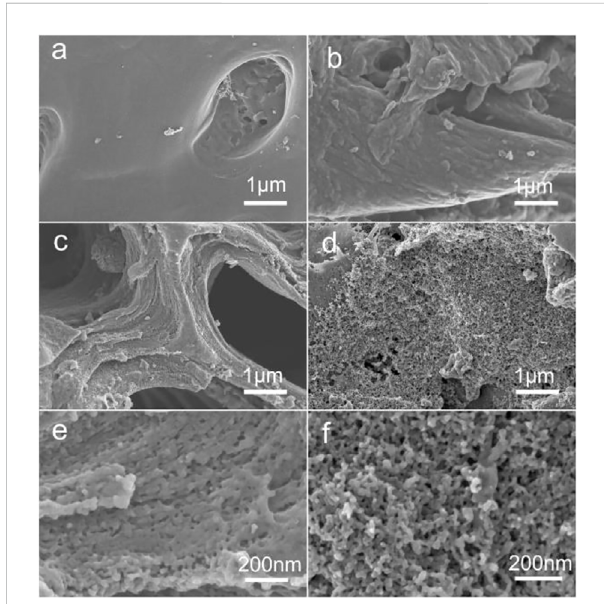
SEM images of peanut shell-derived biochar: (A) carbonized in molten Na 2 CO 3 – K 2 CO 3 salt without hydrothermal pre-treatment, (B) hydrothermal pre-treatment for 12 h before carbonization, (C, E) hydrothermal pre-treatment for 24 h before carbonization, and (D, F) hydrothermal pre-treatment for 48 h before carbonization (Lei et al.,